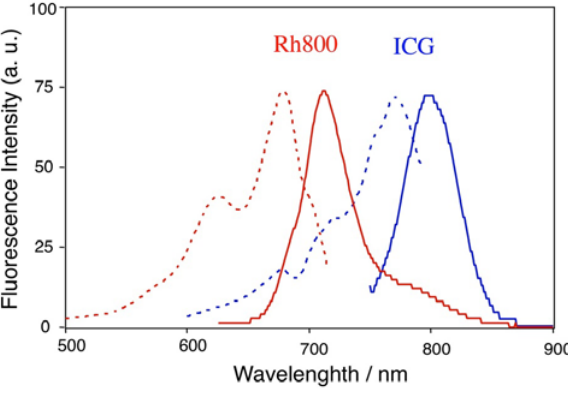
Figure 1. Emission and excitation spectra of Rh800 (red lines) and ICG (blue lines) in PBS. Solid and dotted lines shows emission and excitation spectra, respectively. The concentration of the fluorescent dyes was 40